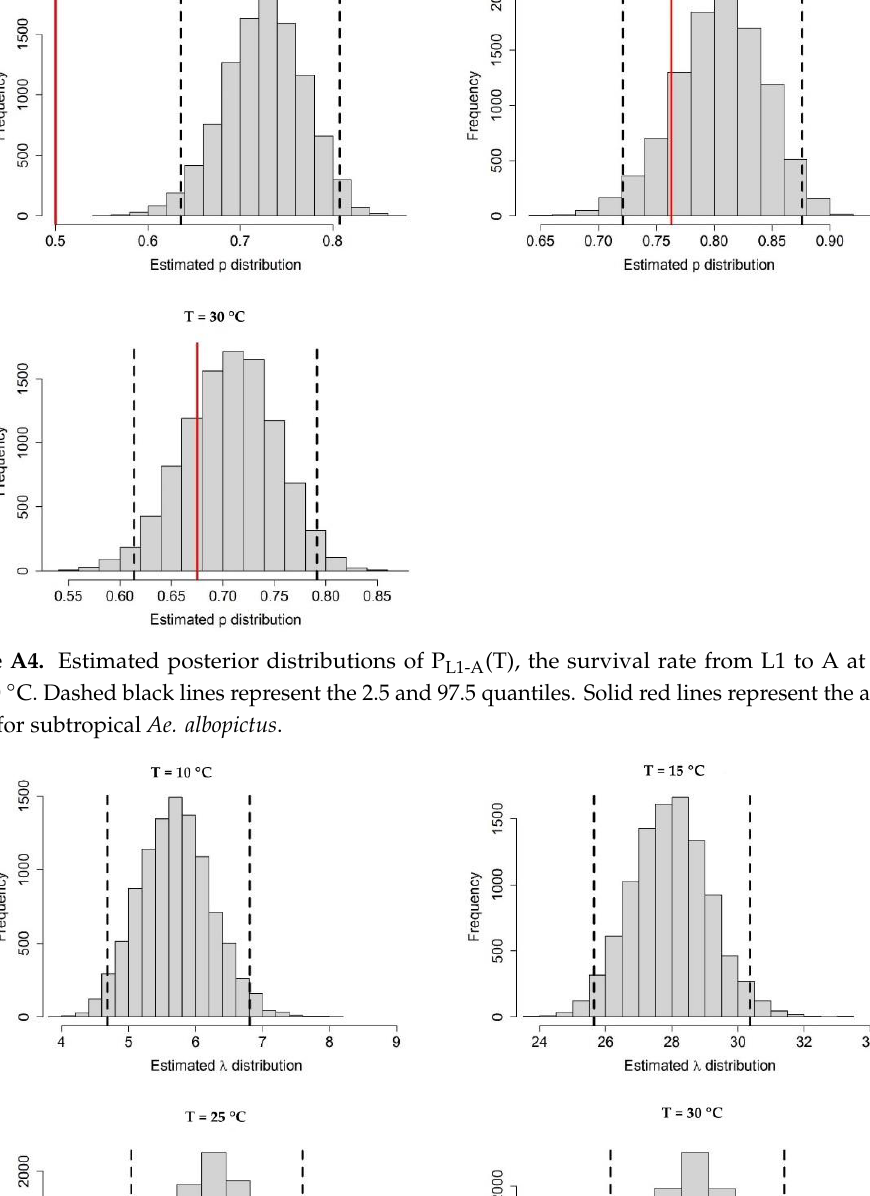
Figure A3. Estimated posterior distributions of Λ L1-A (T), the average duration (days) of development from L1 to A at 15, 25, and 30 °C. Dashed black lines represent the 2.5 and 97.5 quantiles. Solid red lines represent the average value for subtropical Ae. albopictus .